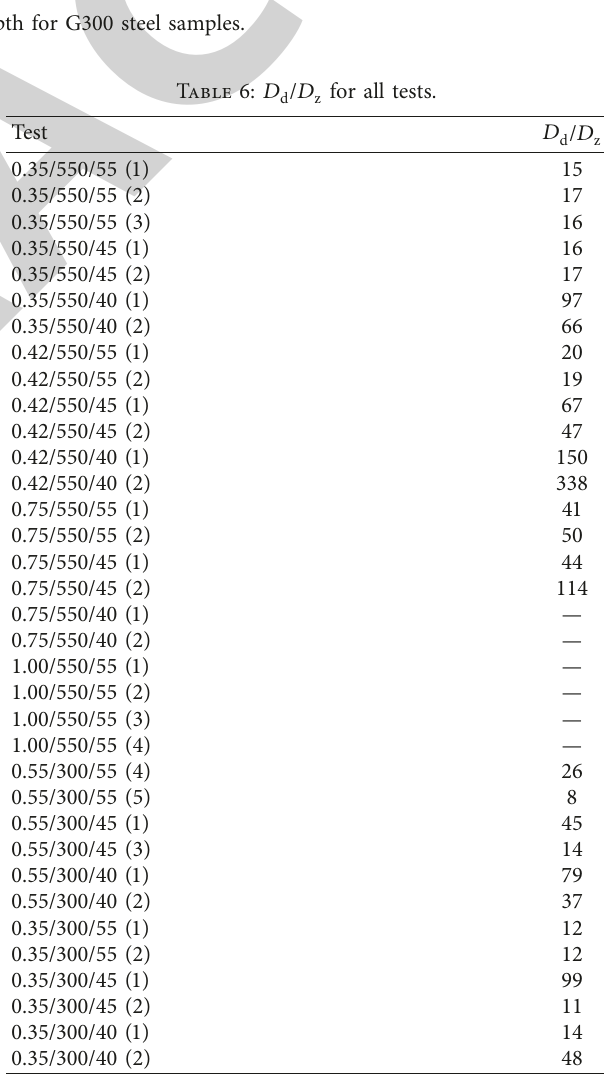
Figure 14: Predicted dent depth for G300 steel samples.